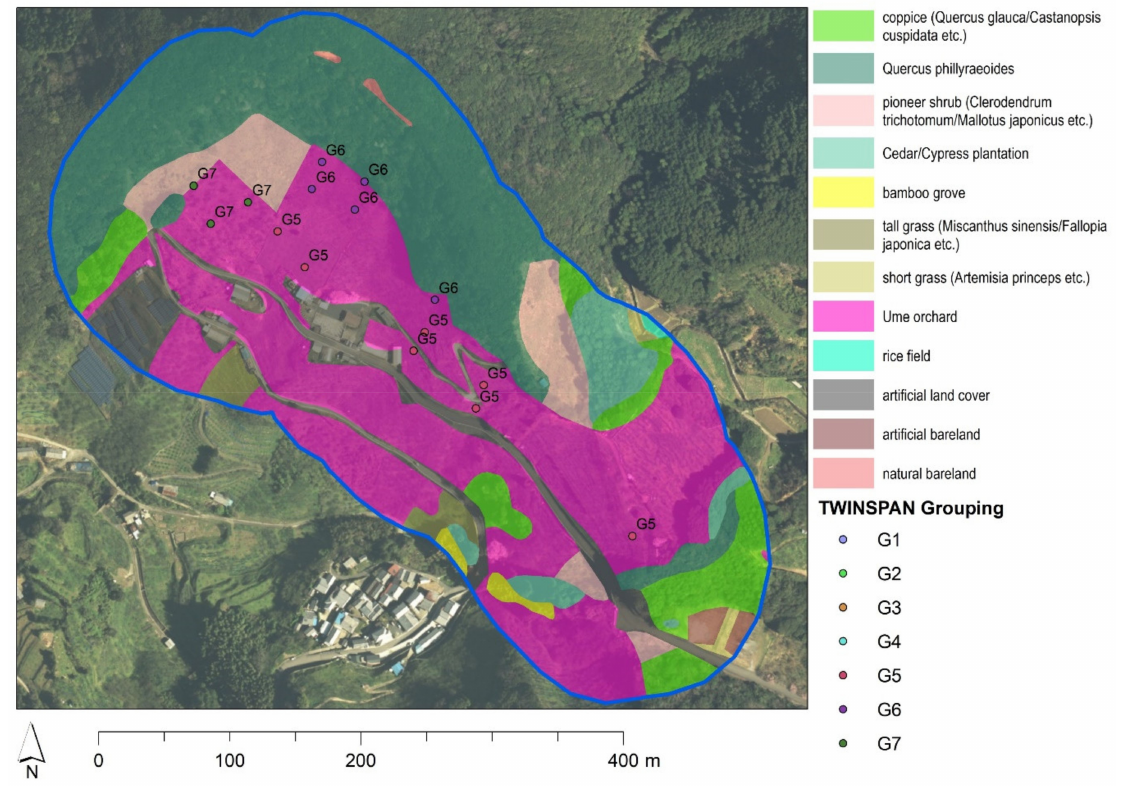
Figure 8. TWINSPAN groupings for traditional sites overlaid onto the vegetation